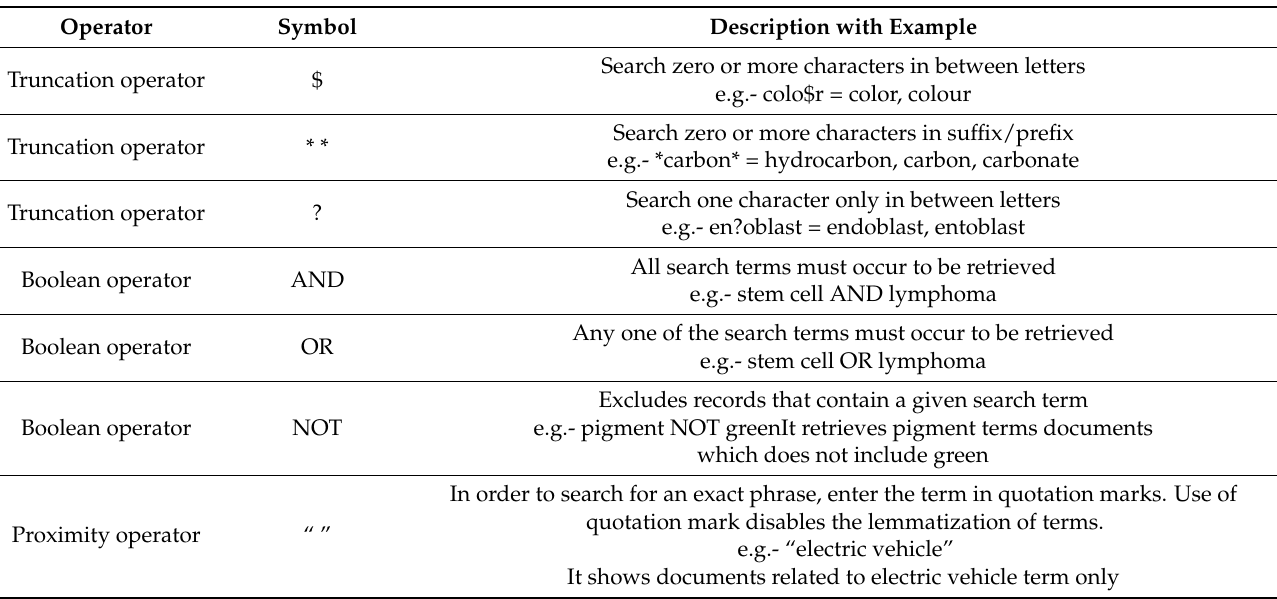
Table 4. Tips to search relevant document result in different ways of keyword search.